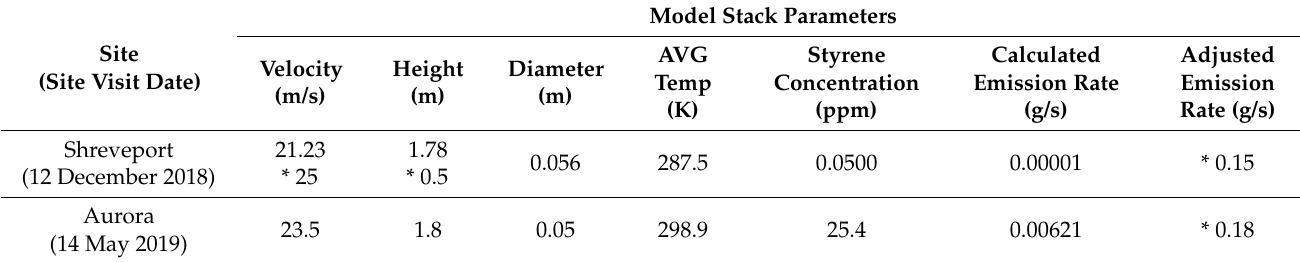
Table 2. Measured and Adjust Model Stack Parameters.